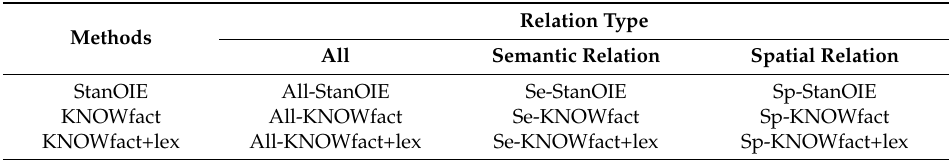
Table 1. Experiment design